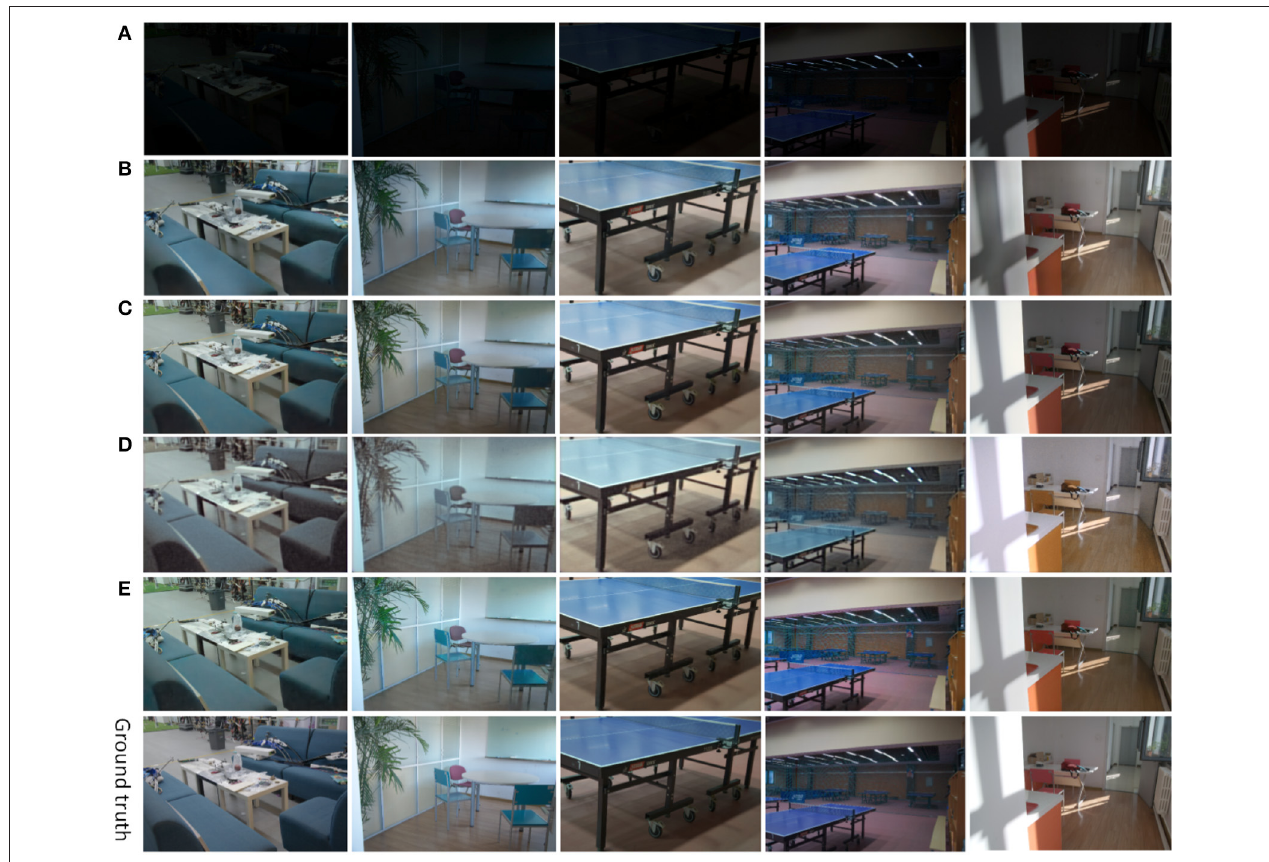
FIGURE 11 | Results of ablation experiments (A) original images of the input, (B) enhanced results of experiment 1, (C) enhanced results of experiment 2, (D) enhanced results of experiment 3, and (E) our method.